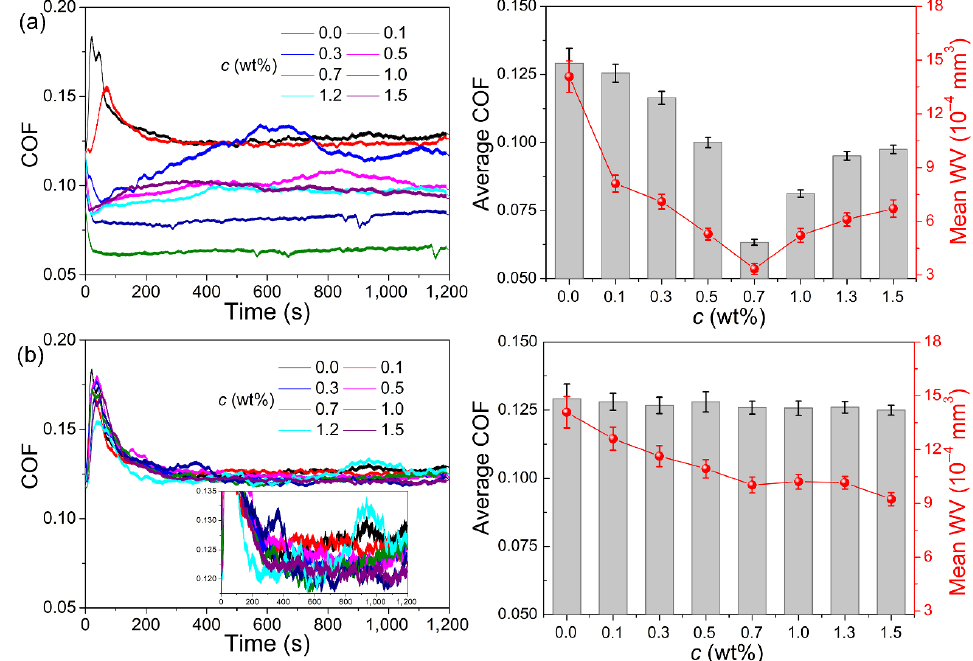
Fig. 8 COF curves, average COF, and mean WV of the disks lubricated with (a) C-g-CNPs and (b) A-g-CNPs dispersions in PEG200 with various concentrations of CNPs under the conditions of 100 N and 20 min. The inset of (b) is the amplifying COF curves on Y